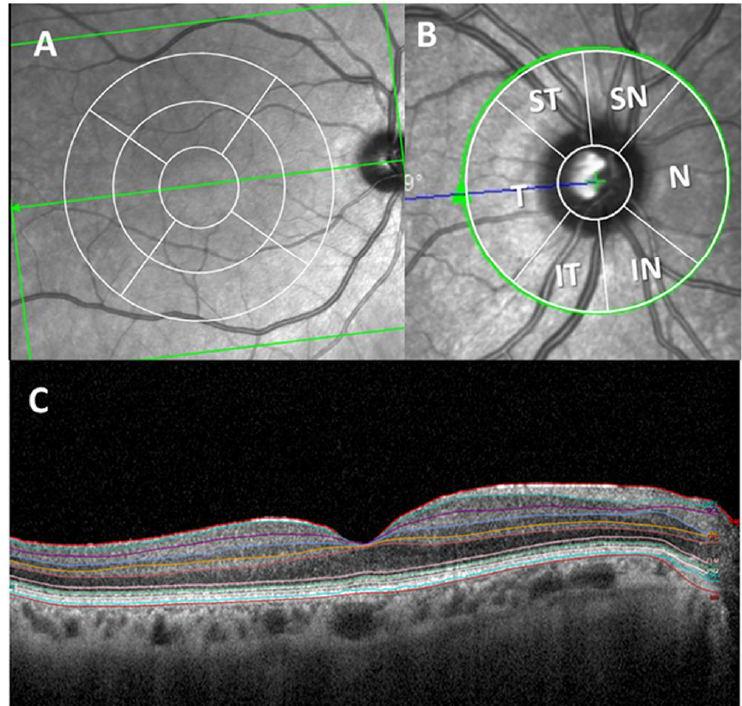
Figure 2. Optical coherence tomography (OCT) report of the retinal thickness analysis. ( A ) Concentric macular rings. ( B ) Peripapillary sectors. ( C ) Macular thickness segmentation of all retinal layers. (ST: supero-temporal; SN: supero-nasal; N: nasal; IN: infero-nasa; IT: infero-temporal; T: temporal and G: